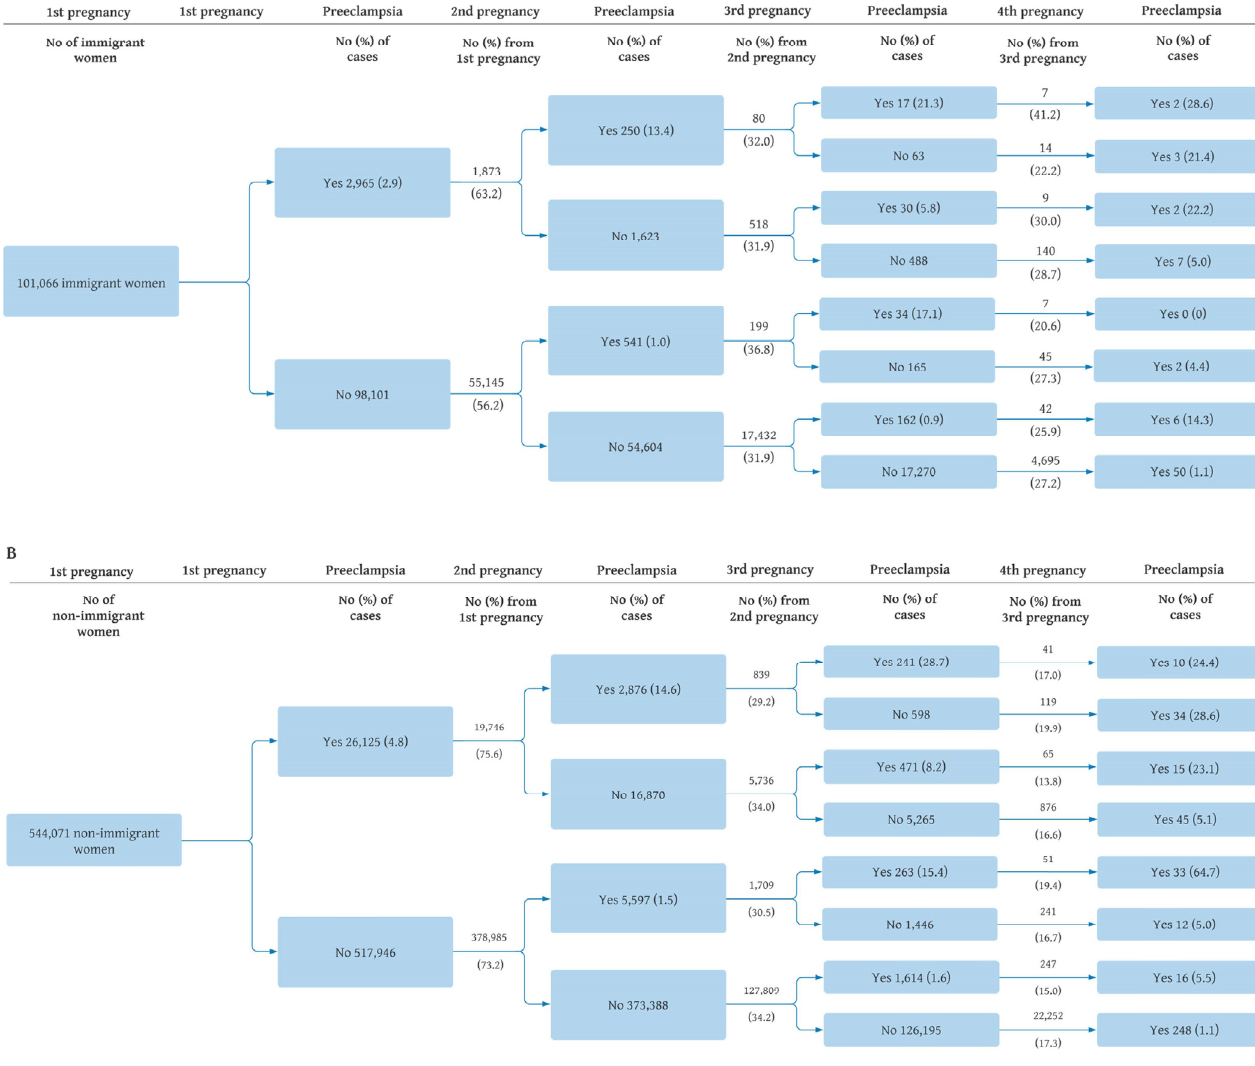
Figure 2. Risk of preeclampsia, up to four subsequent pregnancies in immigrant ( A ) and non-immi- grant ( B ) women, Norway,